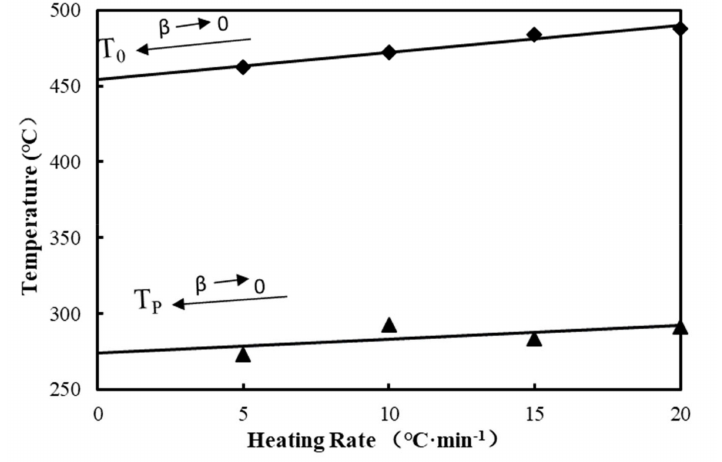
Figure 3. Determination of T 0 and T P with B3 as an